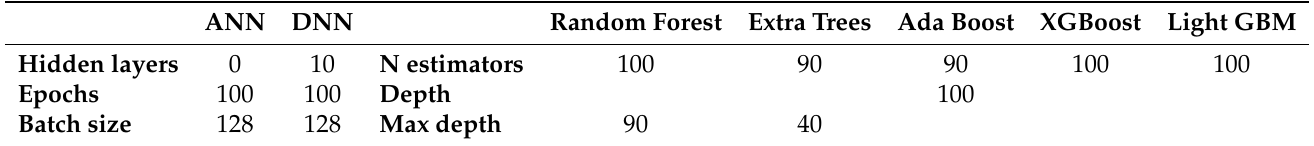
Table 2. Parameters for machine learning